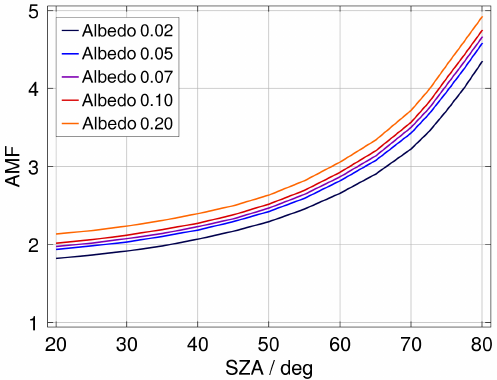
Figure 10. Box-air-mass-factors for NO 2 calculated with SCIA- TRAN for flight geometries, 1.1km flight altitude, 40 ◦ SZA and different ground reflectance values.